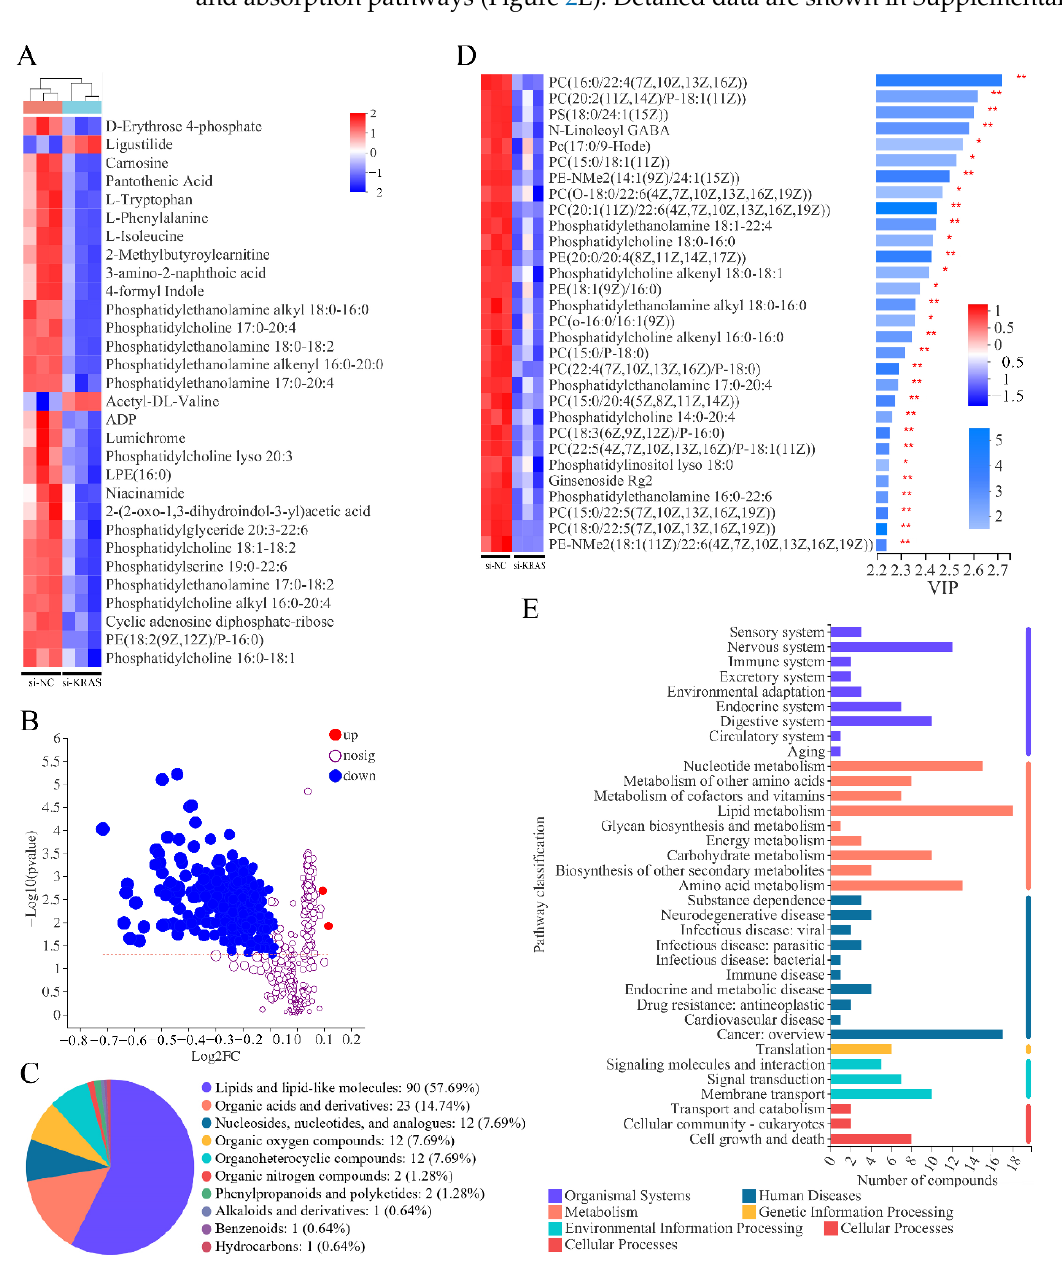
Figure 1. Effects of Kirsten rat sarcoma viral oncogene homolog (KRAS) on cell metabolism in MAC-T cells. ( A ) Heatmap of some of the differential metabolites. In the figure, each column represents a sample, each row represents a metabolite, and the color indicates the relative level of metabolites expressed in the group. Red indicates that the metabolite is expressed at high levels, and blue indicates lower expression. ( B ) Volcano plot of the differentially expressed metabolites. Each dot in the figure represents a metabolite, and the size of the dot indicates the variable importance in the projection (VIP) value. The blue dots are significantly downregulated metabolites, and the red dots are significantly upregulated metabolites. ( C ) Pie chart based on HMDB chemical taxonomy (Super Class) counts for the differential metabolites identified. The color indicates different classes, and the area size indicates the number of metabolites. ( D ) Top 30 differential metabolites from the VIP plot based on the OPLS-DA models. ( E ) KEGG pathway enrichment of differential metabolites. Significant differences are represented with * ( p < 0.05) and ** ( p < 0.01).